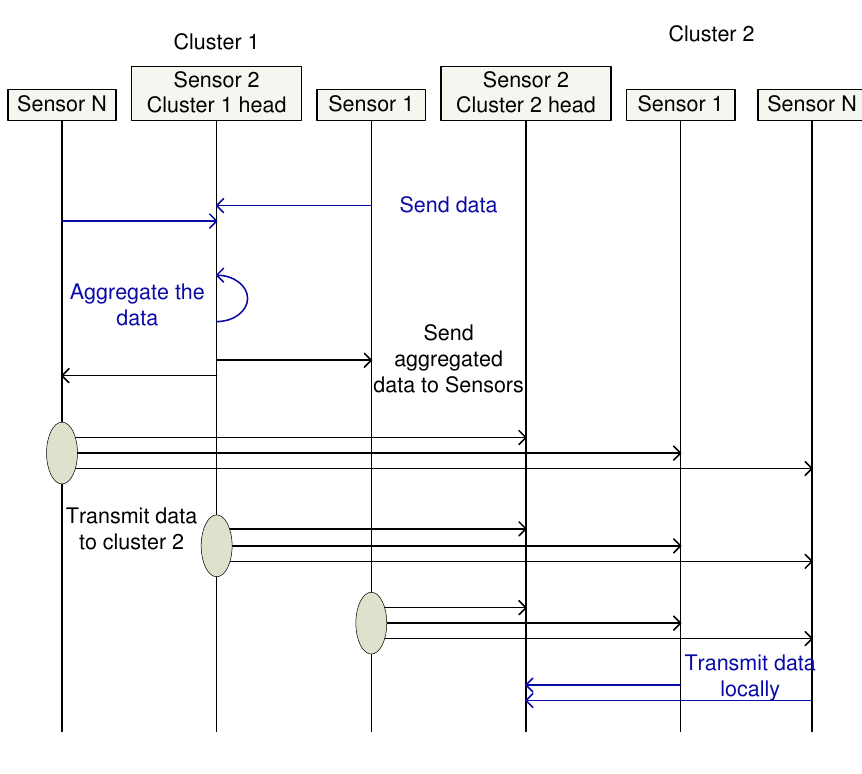
Figure 2. Cooperative